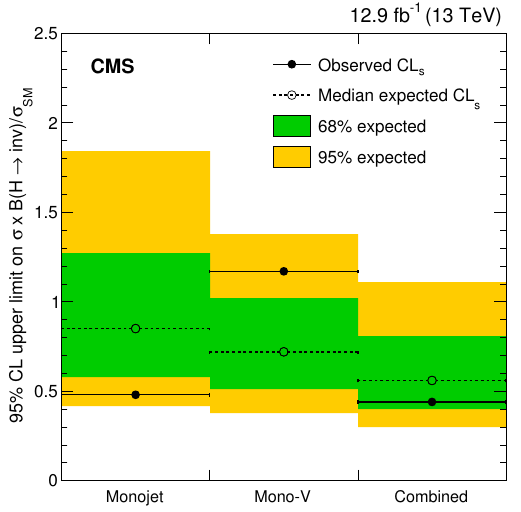
Figure 13 . Expected (dotted black line) and observed (solid black line) 95% CL upper limits on the invisible branching fraction of a 125 GeV SM-like Higgs boson. Limits are shown for the monojet and mono-V categories separately, and also for their